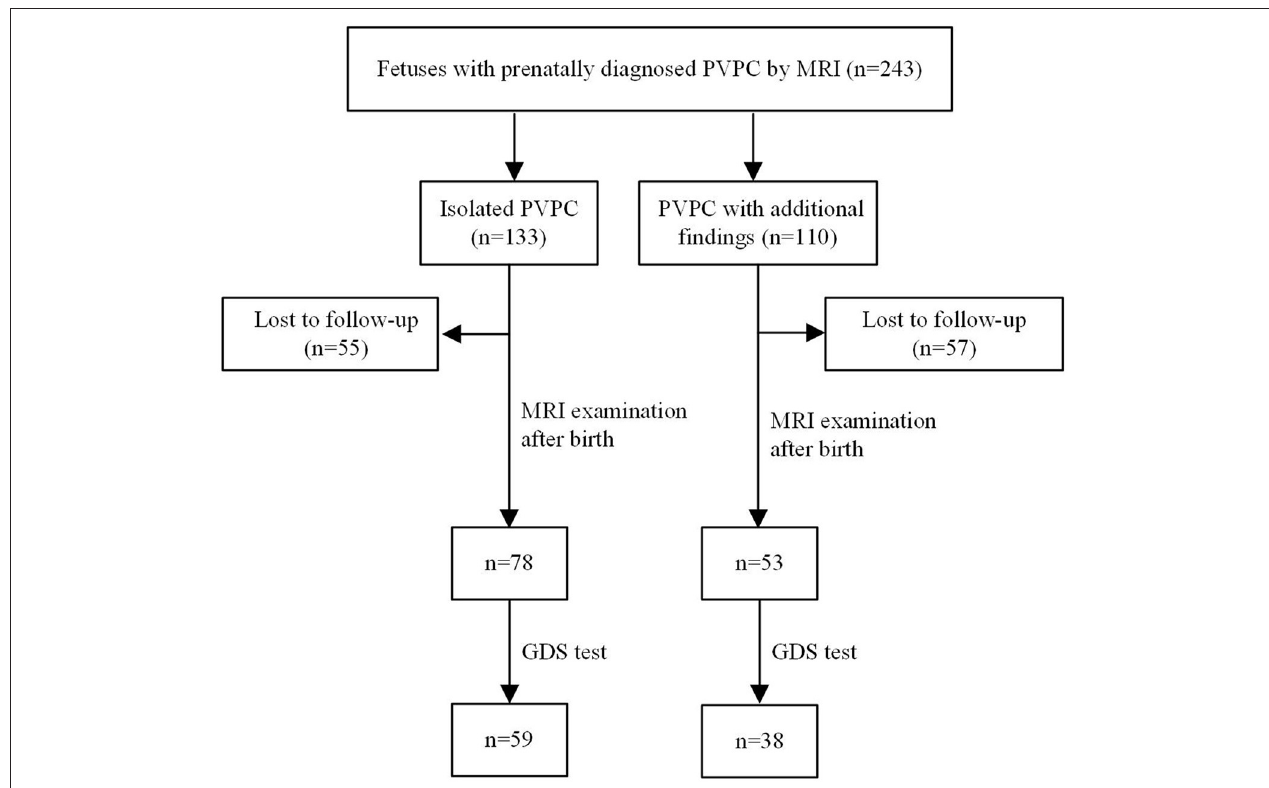
FIGURE 1 | Patients and flow chart of study design. PVPC, periventricular pseudocyst; GDS, gesell developmental